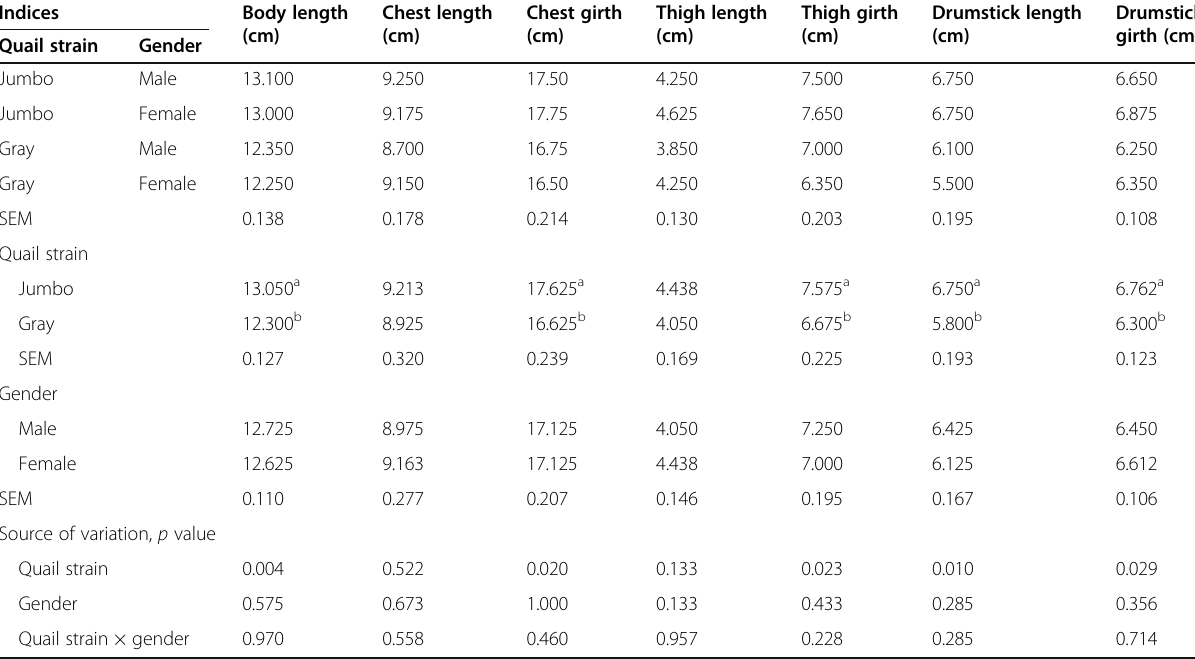
Table 2 Differences in body measurements between Jumbo and Grey Japanese quail strains Indices